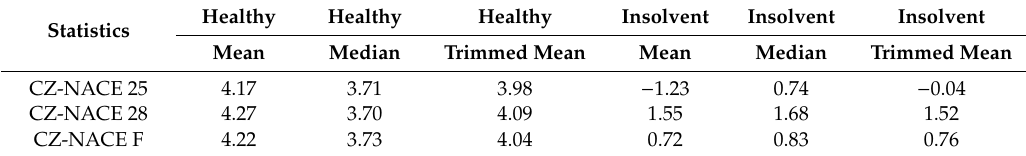
Table 2. Descriptive statistics for Altman’s Z-score in